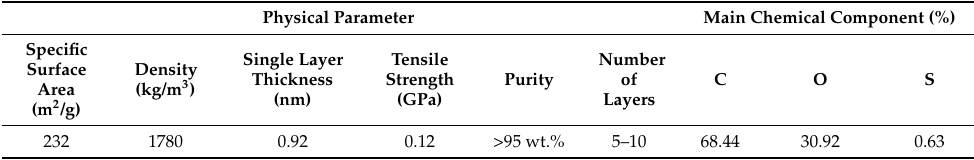
Table 2. Physical and chemical properties of